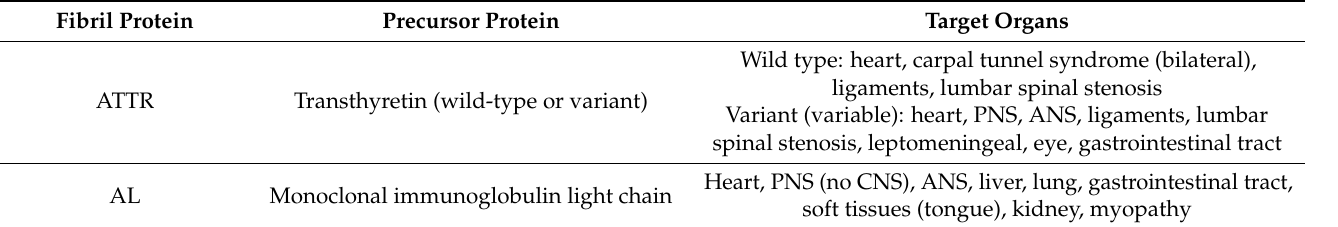
Table 1. Main amyloid types with possible cardiac involvement. Fibril Protein Precursor Protein Target Organs Wild type: heart, carpal tunnel syndrome (bilateral), ligaments, lumbar spinal stenosis ATTR Transthyretin (wild-type or variant) Variant (variable): heart, PNS, ANS, ligaments, lumbar spinal stenosis, leptomeningeal, eye, gastrointestinal tract AL Monoclonal immunoglobulin light